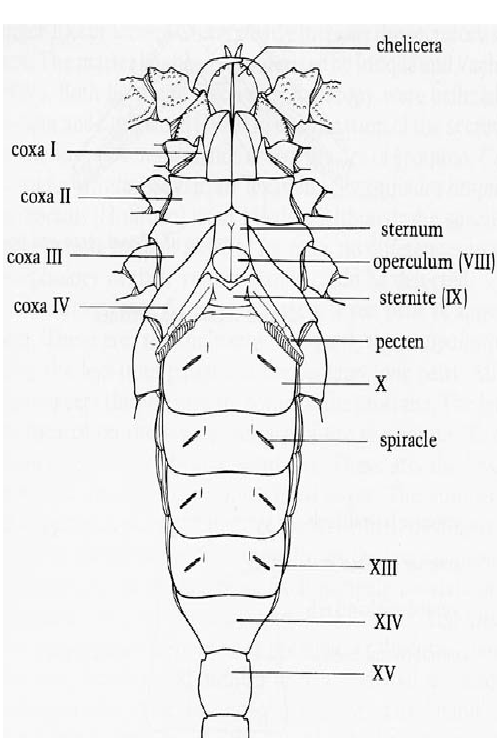
Figure 3: Scorpion ventral view